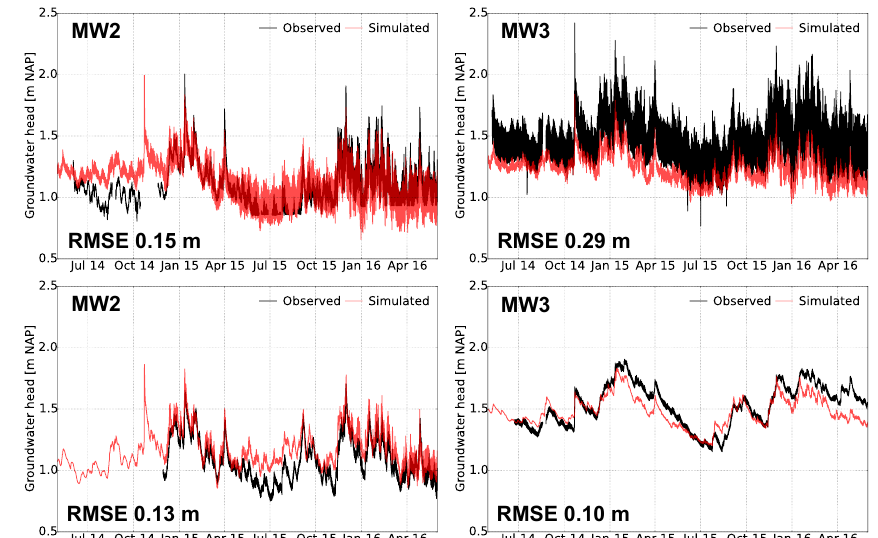
Figure 7. Observed and simulated groundwater head in MW 2, 3, 7, and 8 (in aquifer 2: see Fig. 2), from May 2014 to June